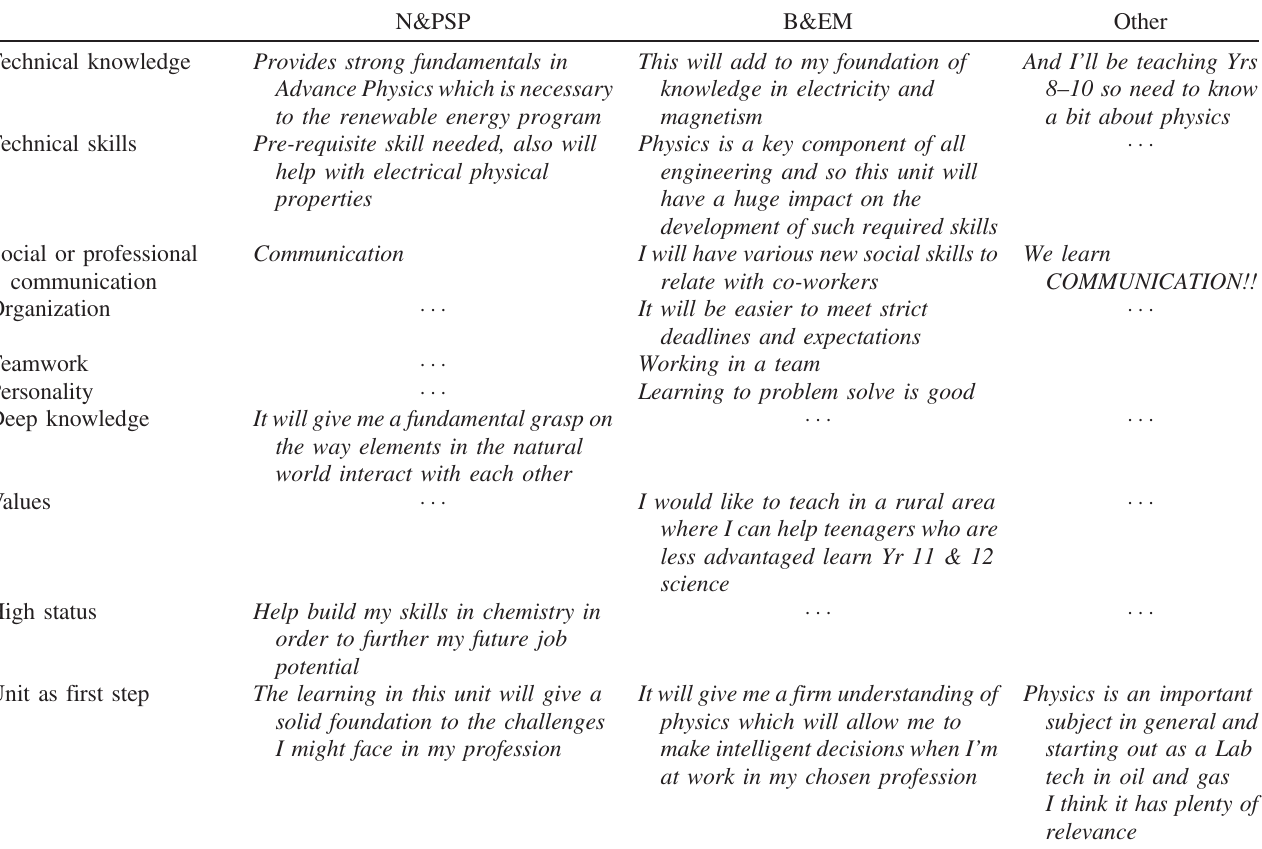
TABLE V. Student perceptions of how learning in the unit will contribute to their development as a professional in their chosen field, by occupational